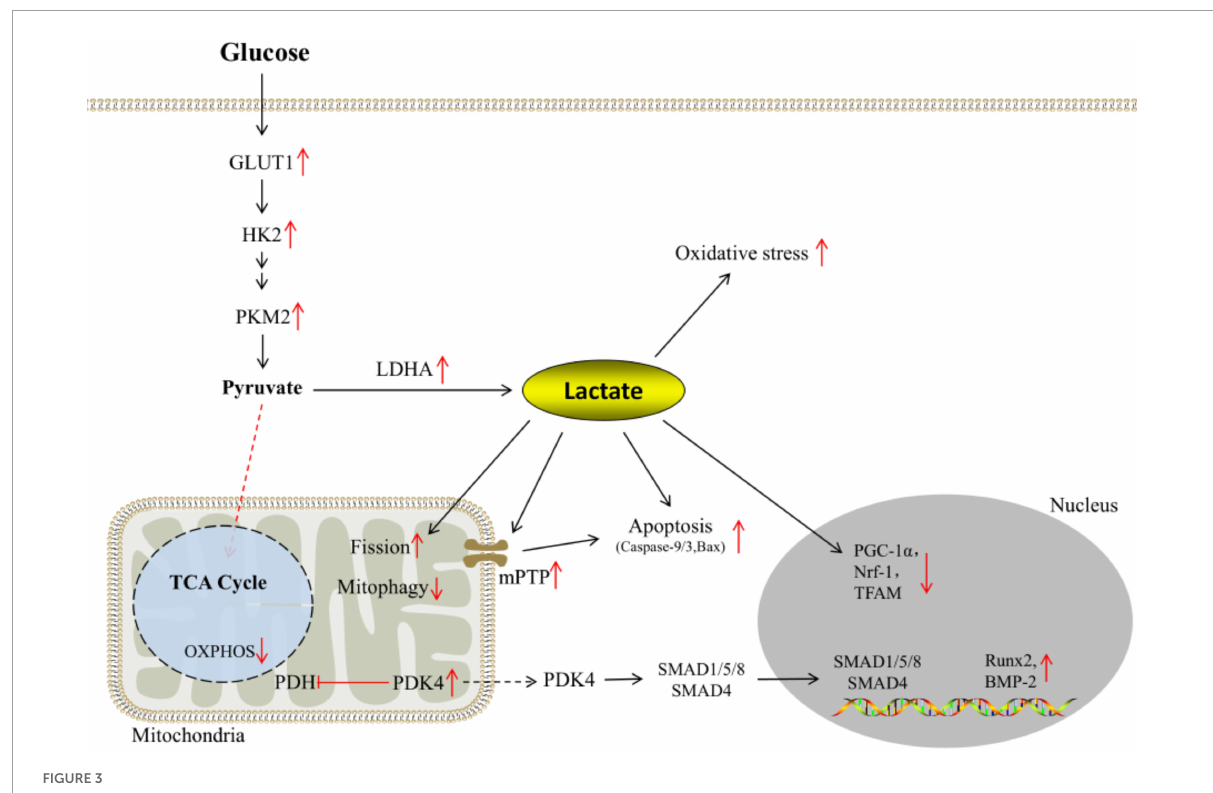
FIGURE3 Reprogramming of glucose metabolism under calcifying